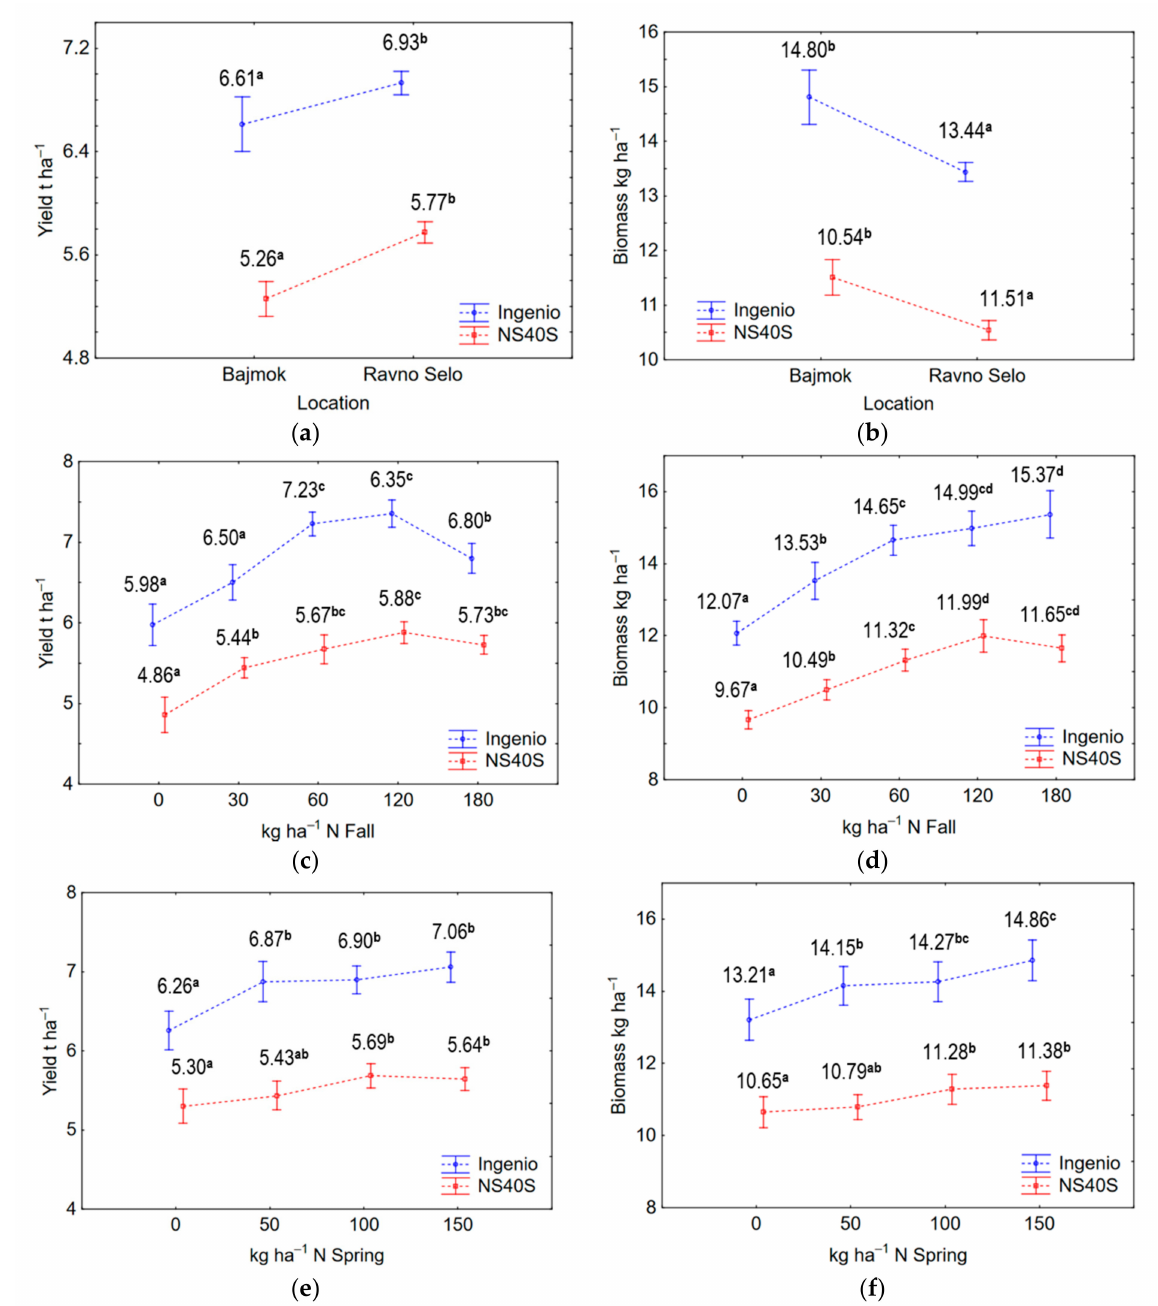
Figure 4. The effects of location on yield ( a ) and biomass ( b ), fall N fertilizer application on yield ( c ) and biomass ( d ), and spring N fertilizer application on yield ( e ) and biomass ( f ) of Ingenio and NS40S varieties for 2018 growing season. The letters on the graph represent different classes obtained by ANOVA with p = 0.05 level of